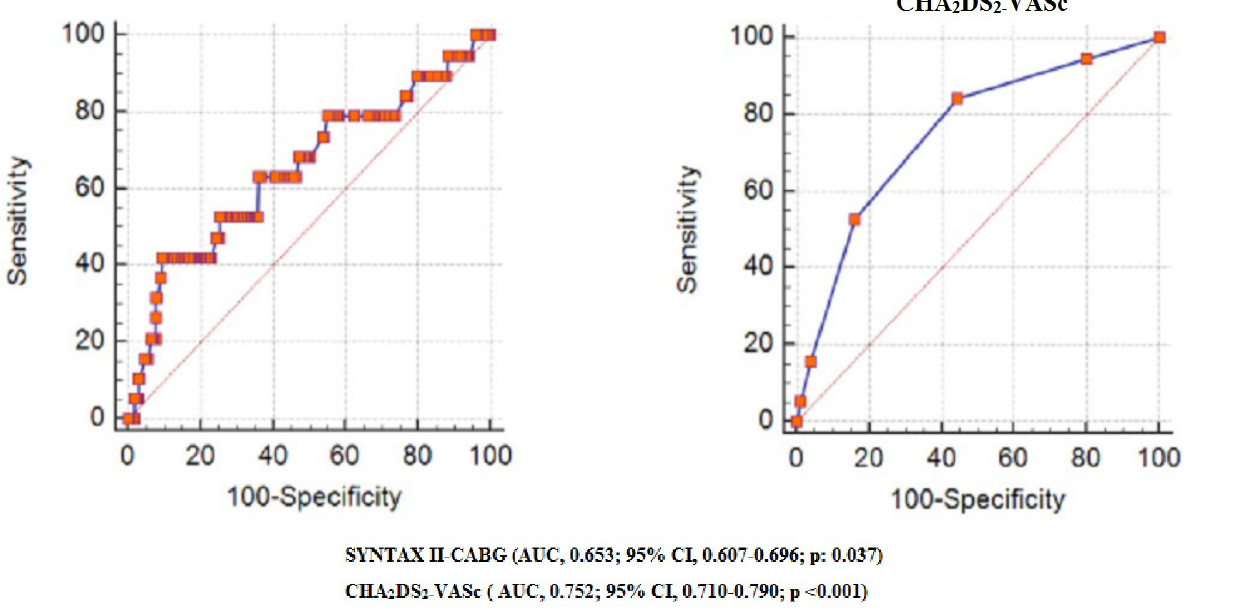
Fig. 1 – Receiver-operating characteristic curve analysis of SYNTAX II-CABG and CHA AUC=area under the curve; CABG=coronary artery bypass grafting; CI=confidence